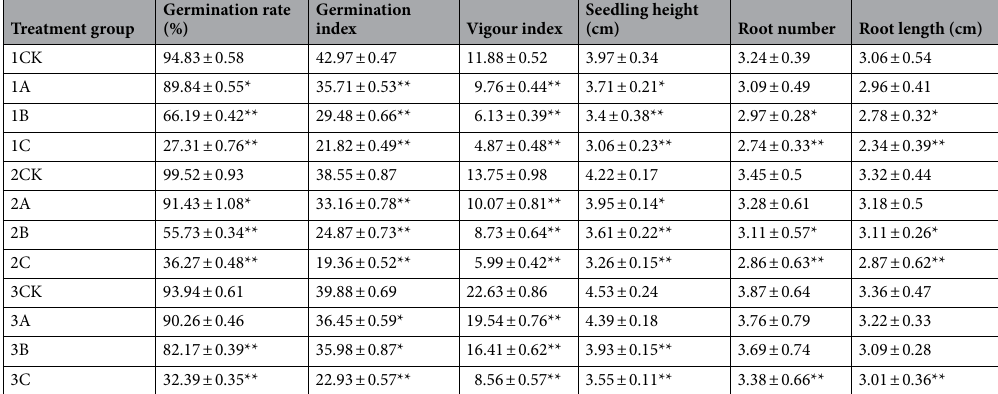
Table 1. Seed vigour and seedling growth indexes of rice subjected to different doses of N ion beam irradiation. The values are presented as the mean ± SE (n = 3). * and ** denote significance at the P < 0.05 and P < 0.01 levels, respectively, compared with the control group.